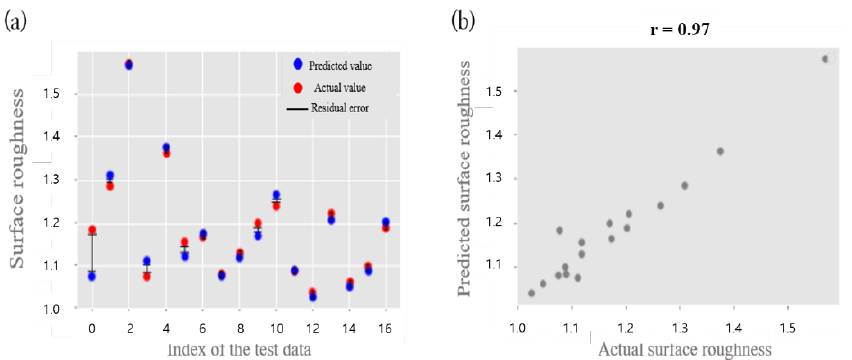
Figure 9. ( a ) Residual error plot of real values and predicted values. ( b ) Scatter plot of real values and predicted values.